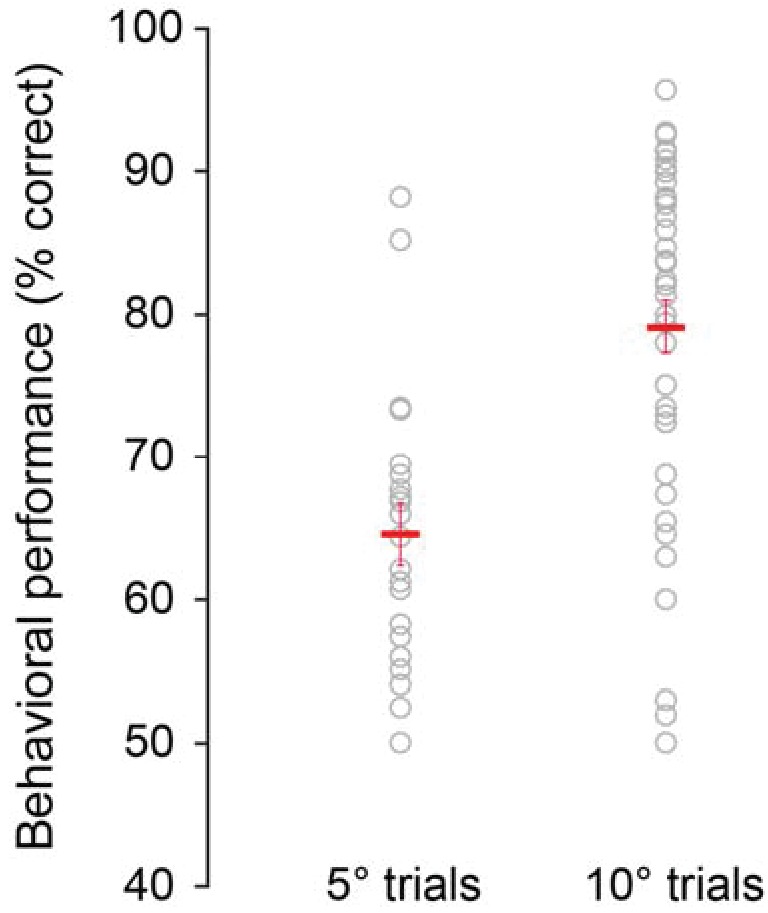
Behavioral performance depends on task difficulty.Animals performed more poorly when they discriminated small orientation differences (±5o; mean across sessions: 64.58 ± 2.19% correct responses) compared to larger orientation differences (±10o; mean across sessions: 79.17 ± 1.85% correct responses, p=4.03 10−5, rank-sum test). Each circle represents one session. Red crosses mark the mean performances across sessions.